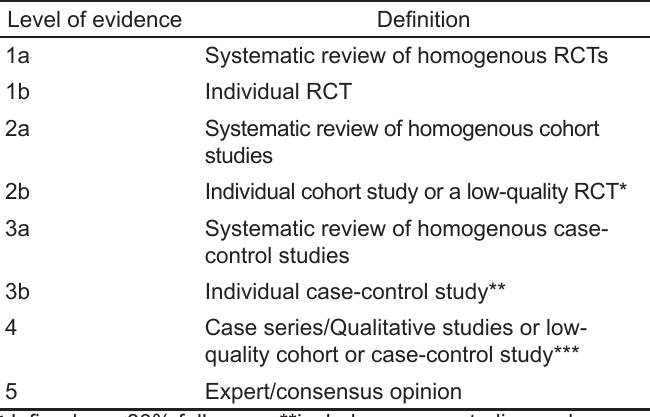
Table 1a. Oxford Centre for Evidence-Based Medicine levels of evidence. 20